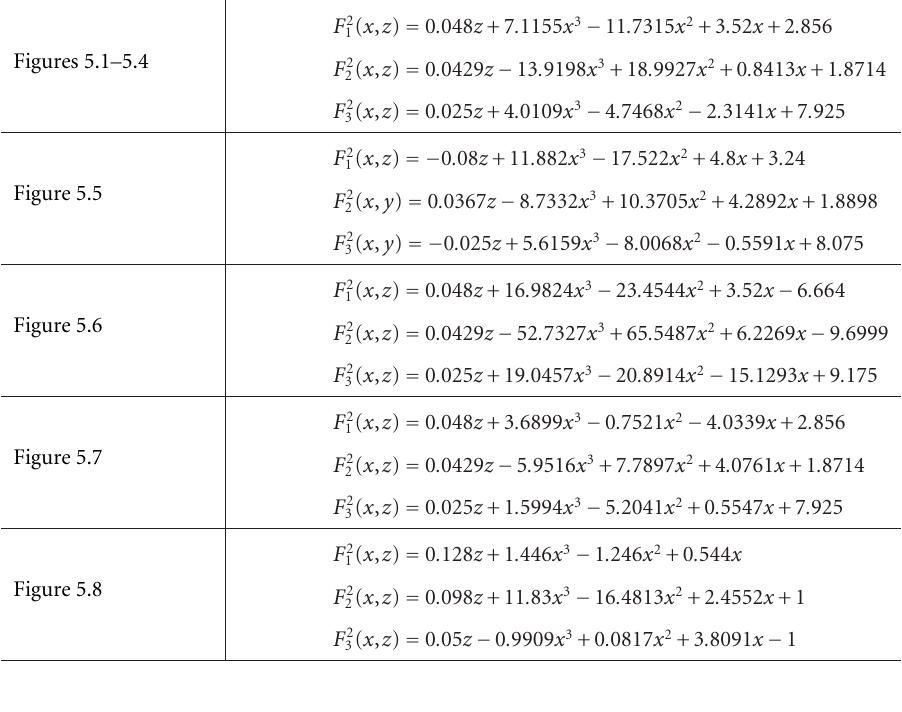
Figures 5.1–5.4